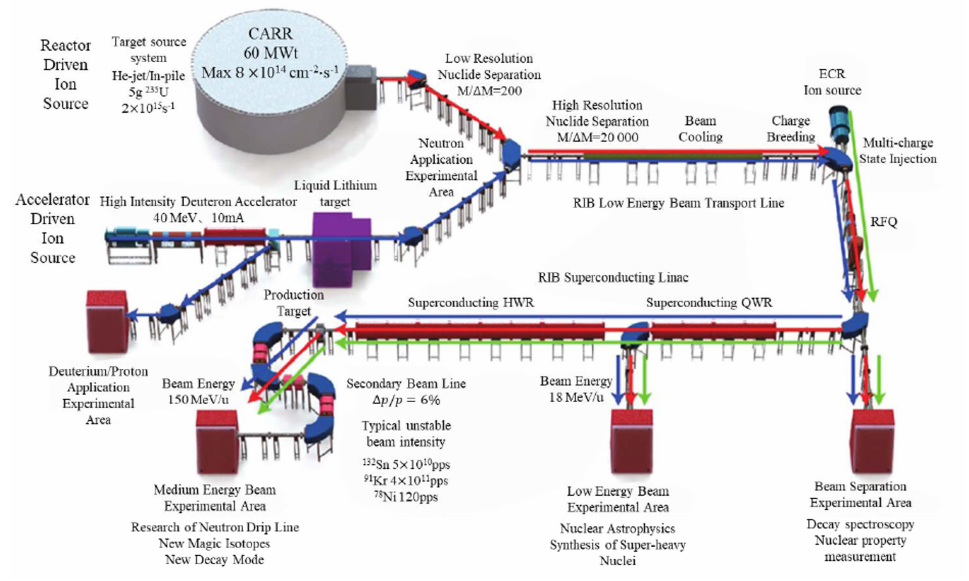
Figure 1. Layout diagram of BISOL